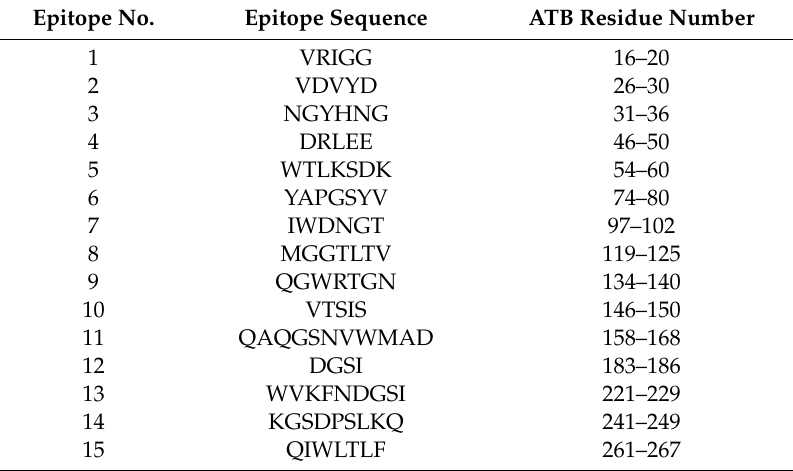
Figure 3. Binding of antiabrin sera to ATB peptide array. Set of 15-mer biotinylated peptides spanning amino acid sequence of B subunit of abrin were immobilized on microtiter plates and incubated with antiabrin antibodies R1 (black), R2 (red), R3 (purple), or M1 (green). Plates were then washed, AP-conjugated secondary antibody was added, and antibody binding in each well was determined. Table 3. ATB immunodominant epitopes.